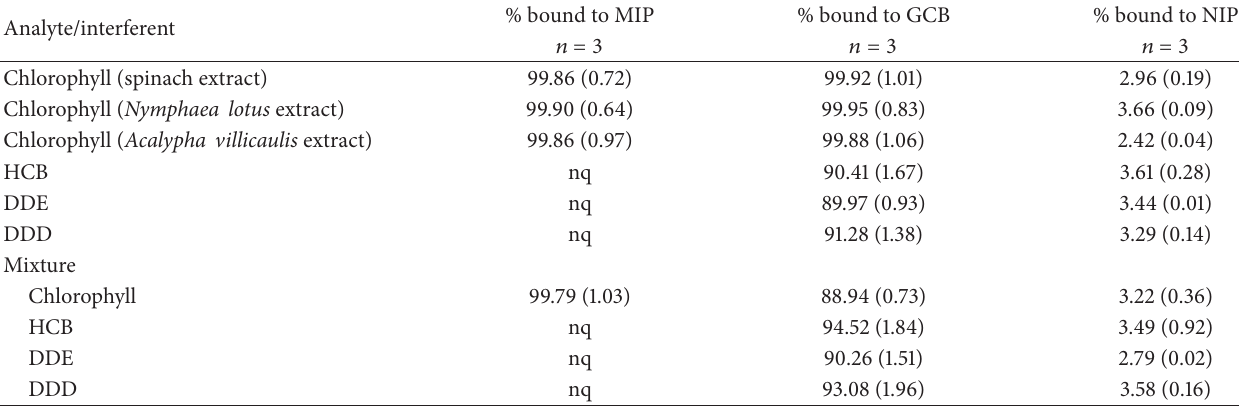
Table 1: A Comparison of selectivity of various adsorbents in specifically binding chlorophyll and/or pesticides at optimized conditions. Analyte/interferent